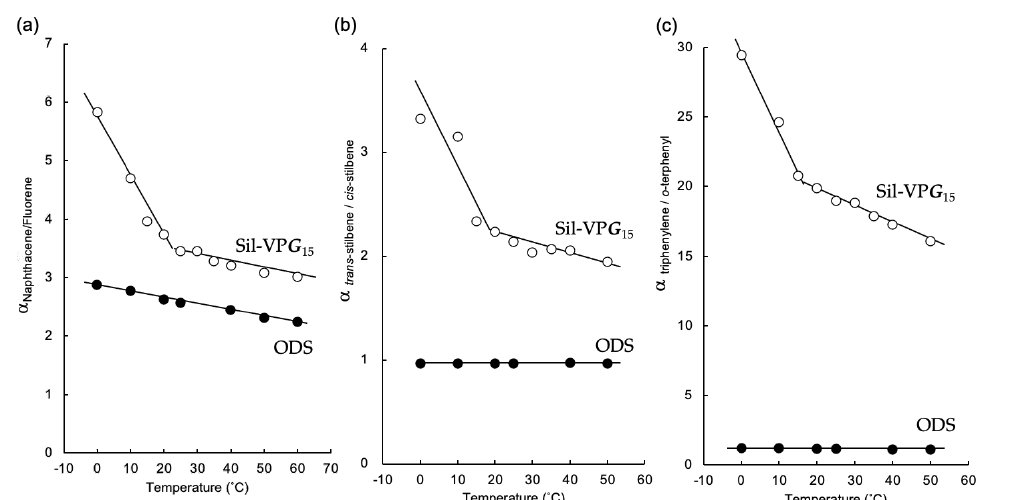
Figure 6. Temperature dependence of the separation factors for ( a ) naphthacene/fluorene, ( b ) trans -stilbene/ cis -stilbene and ( c ) triphenylene/ o -terphenyl using Sil − VP G 15 and ODS as stationary phases. Mobile phase: Acetonitrile. Column temp.: 25 °C. Flow rate: 1.0 mL min −1 .